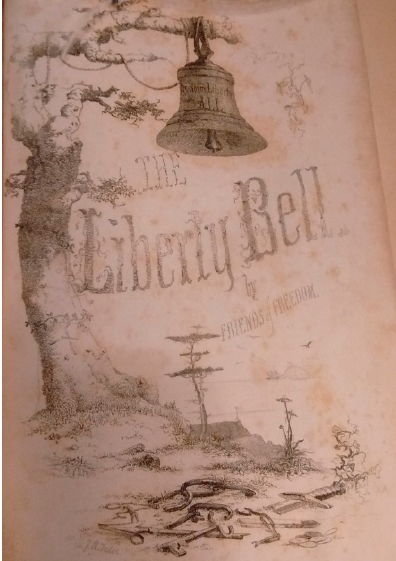
Figure 1. Frontispiece to The Liberty Bell for 1848 [10], in which “Runaway Slave” was first published. Reproduced by permission of the Armstrong Browning Library.